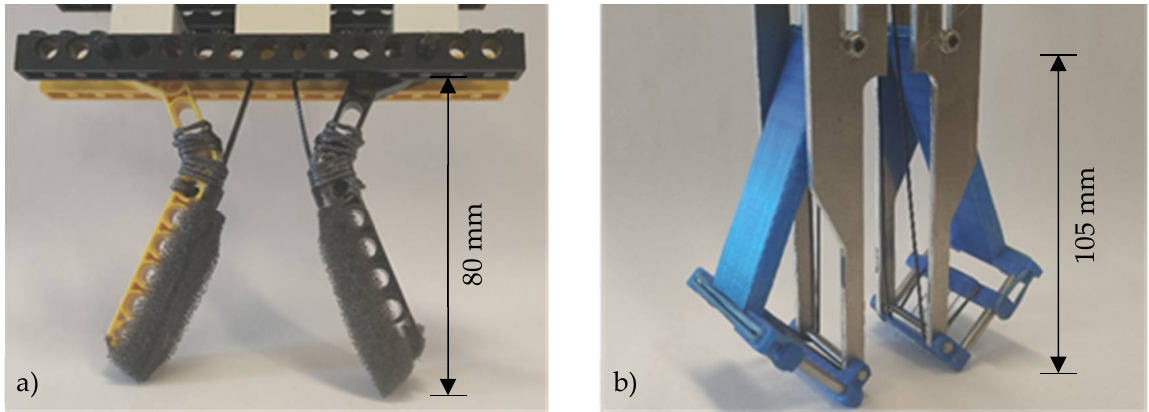
Figure 2. The two grippers employed in the experiments: a ) two-finger gripper; b ) needle gripper.